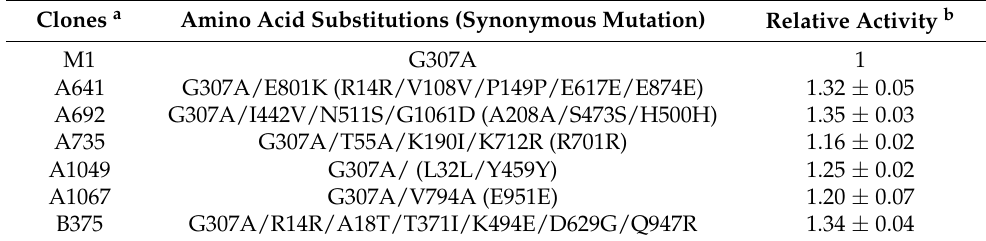
Table 1. Positive variants obtained by directed evolution.